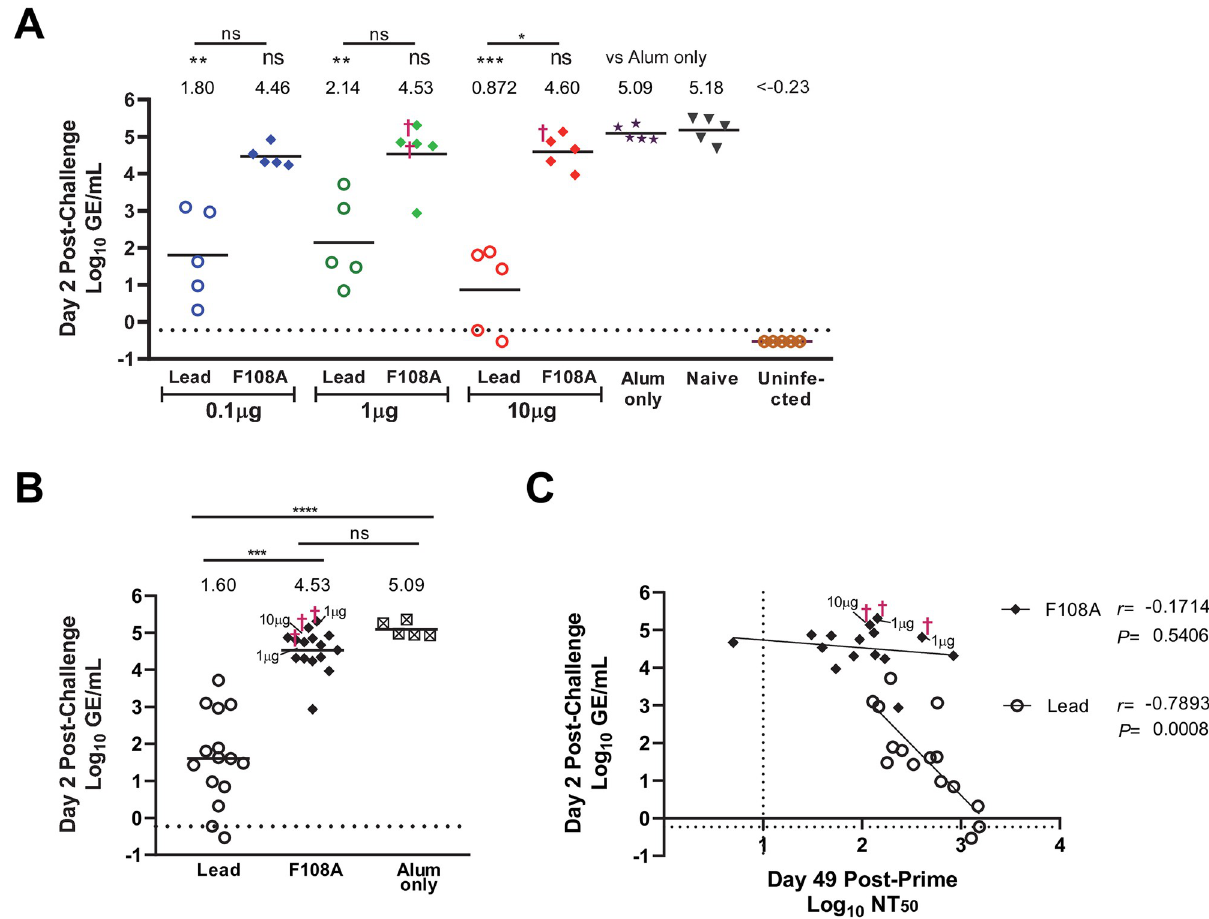
Fig 6. Immunization with lead, but not F108A VLP, significantly reduces RNAemia, which inversely correlates with nAb responses. Animals were challenged with 5,000 FFU of ZIKV strain (Nica 2–16) SC at Day 52 as depicted in Fig 3A. (A) Viral load in serum was measured on day 2 post- challenge by RT-qPCR. Each symbol represents the log 10 GE/mL for an individual mouse, horizontal bars and values above each group show group means, significance values compared to the Alum-only group are just above group mean values, and the bars and significance levels on top were obtained by comparing lead and F108A groups. The dotted line is the limit of detection (LOD) of the assay set based on the lowest log GE/mL detected (0.59 GE/mL), and the symbol † denotes a mouse with a lethal infection. Measurements below the LOD were assigned a value of half the LOD. Statistical comparisons were performed using Kruskal-Wallis test followed by Dunn’s multiple comparisons tests (ns, not significant; � P < 0.05; �� P < 0.01; ��� P < 0.001; ���� P < 0.0001). (B) Combined lead and combined F108A VLP groups were compared to the Alum-only group. Individual viral load values, assay LOD, and the symbol † designation are as in (A). (C) The relationships between NT 50 and viral load (both log 10 transformed) for the combined lead VLP groups and the combined F108A VLP groups were assessed by Spearman correlation analysis with resulting r and P values shown.